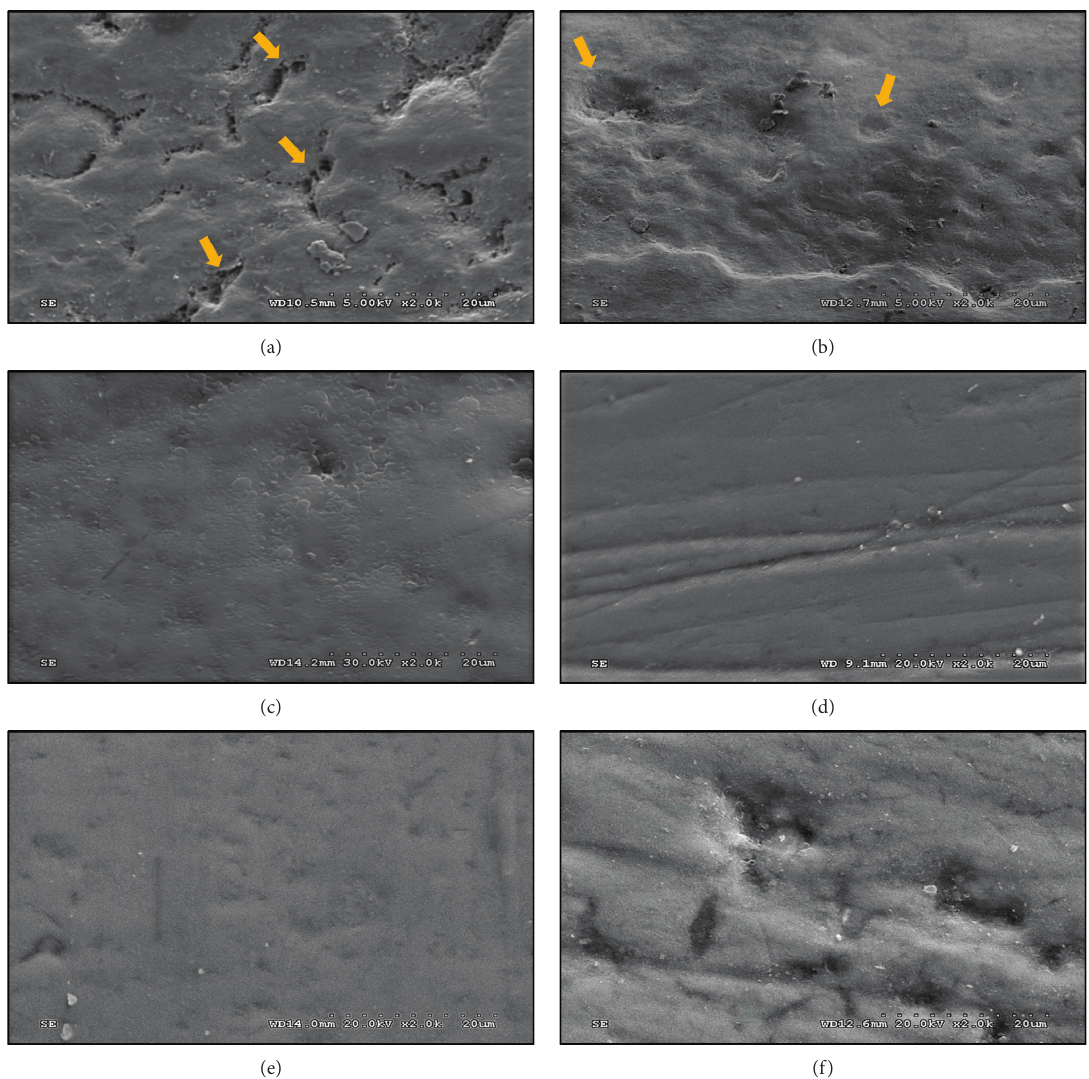
Figure 4: The scanning electron photomicrograph (SEM, x2K) of the demineralized surface of enamel, showing outlines of enamel prism/ rod with the remnant of interprismatic enamel (yellow arrow) (a), followed by remineralization with fluoride varnish, showing incomplete filling of the porosities (yellow arrow) (b), nano-hydroxyapatite toothpaste (c), 20% nano-hydroxyapatite gel (d), 30% nano-hydroxyapatite gel (e) compared to no treatment group